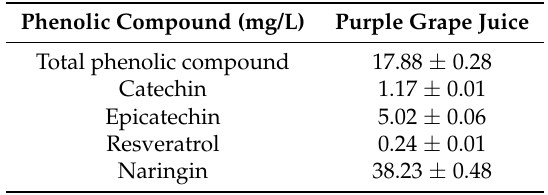
Table 2. Total and isolated phenolic content in purple grape juice ( Vitis labrusca